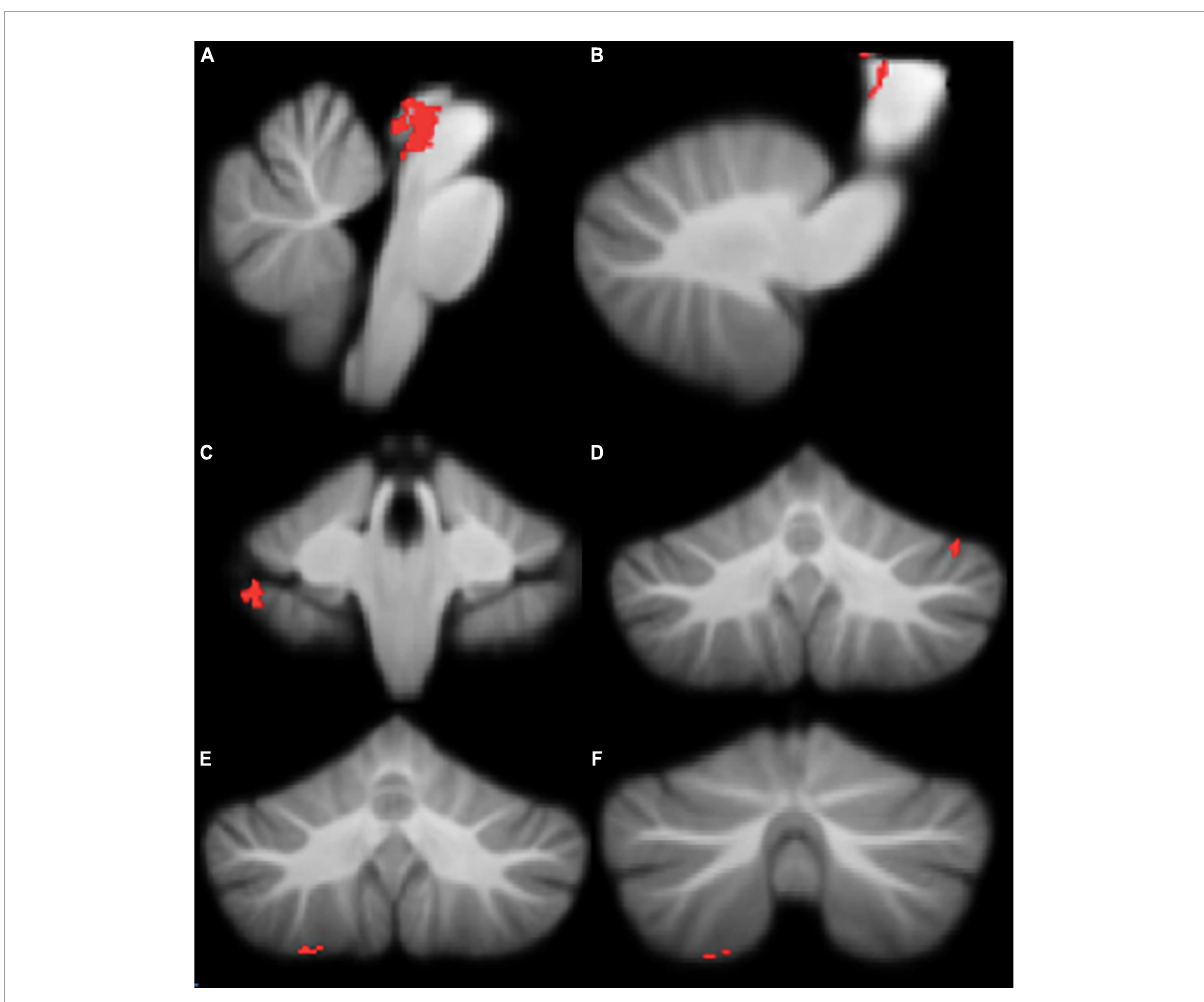
FIGURE3 Significant positive correlations between grey Movement Assessment Battery for Children-2 (MABC-2) total percentile scores. (A) brainstem; (B) brainstem; (C) right lobule VIIb; (D) left crus I; (E) right lobule VIIIa; (F) right lobule VIIIa. All results reported with TFCE correction, uncorrected across contrast at p < 0.01; cluster size threshold at 50 voxels.